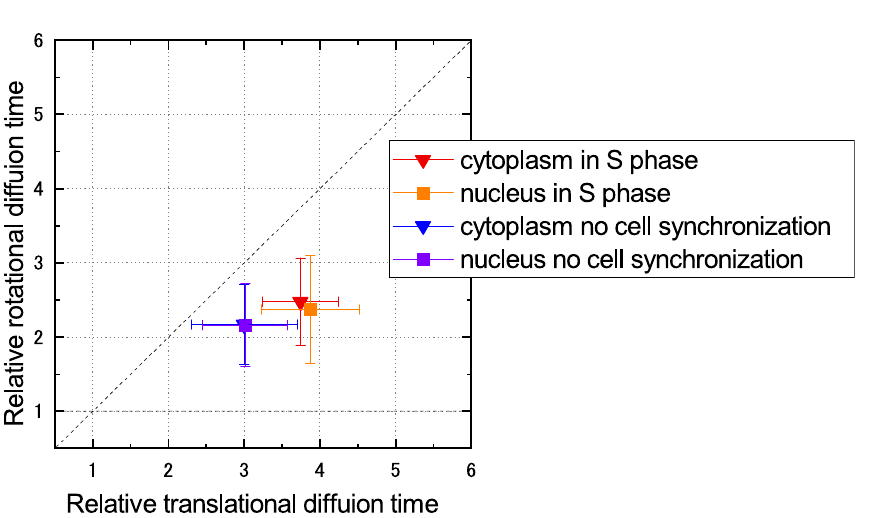
Figure 6. Pol-FCS result of GFP in living cells. The translational/rotational diffusion times were normalized by these values of GFP solution in PBS. The samples were HeLa cells expressing GFP with/without cell cycle synchronization at S phase. Error bars show standard deviation ( n =